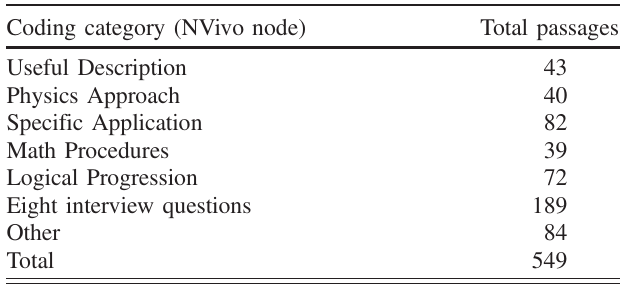
TABLE II. Total number of transcript passages from all eight students assigned to each coding